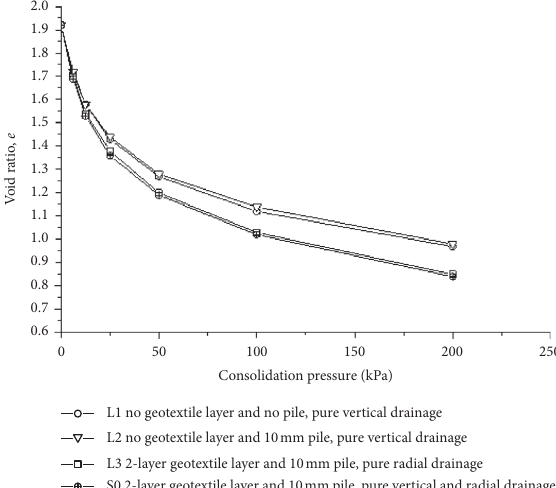
Figure 7: Curves of void ratio versus consolidation pressure for tests of Group A (L1, L2, L3,